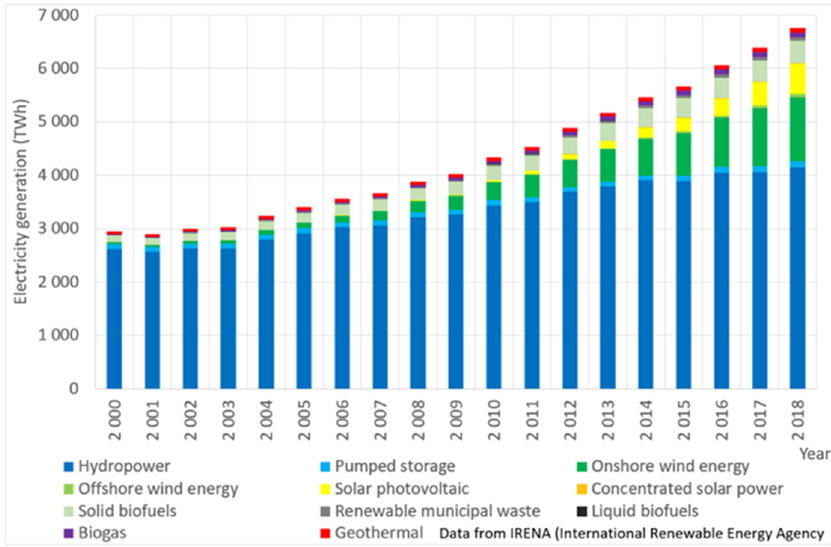
Figure 2. Global renewable electricity generation trend [14] .